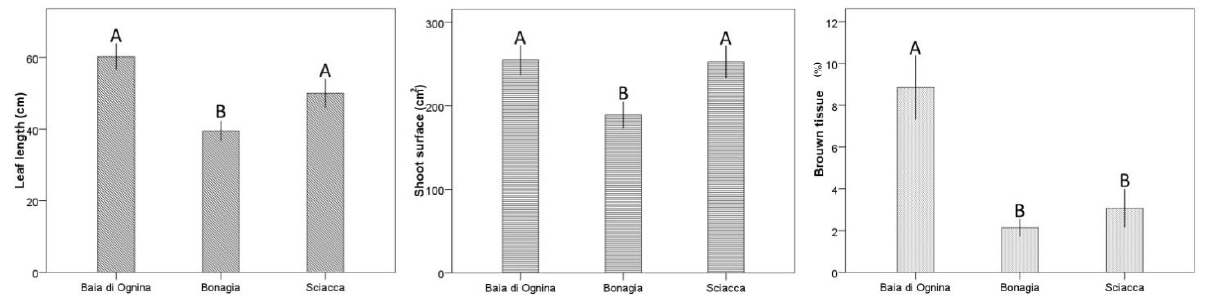
Figure 5. Mean ( ± SE) values of biometric variables at the sampling stations. Letters over the bars indicate a homogeneous group checked by a post hoc